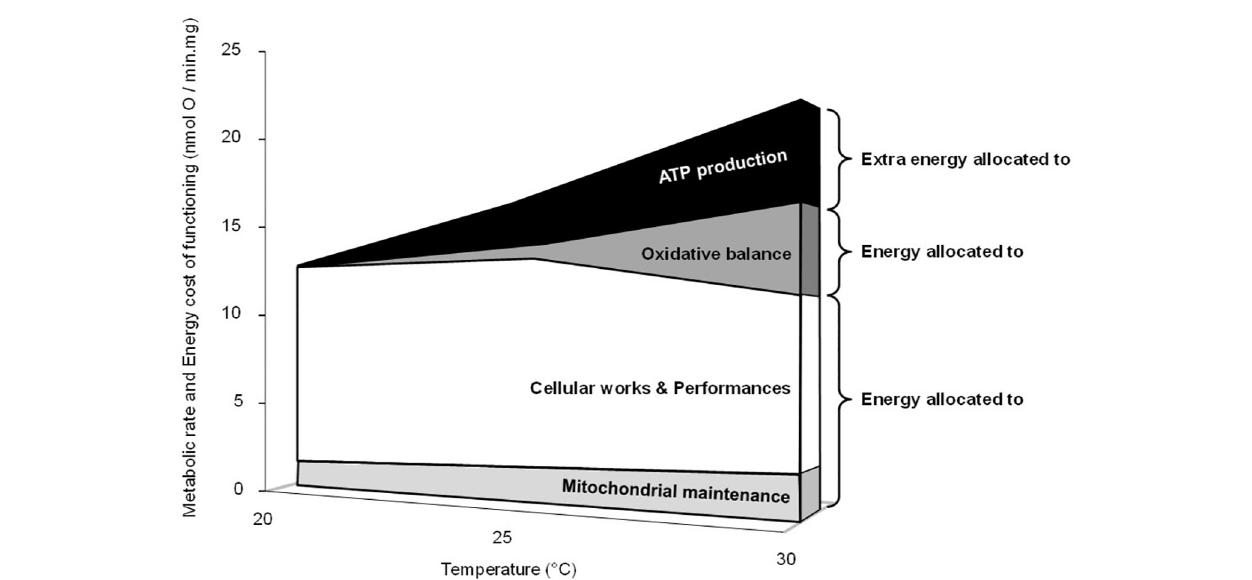
FIGURE 6 | Synoptic summary of the effects of acute temperature change on mitochondrial metabolism and energy costs. The upper limit in the figure represents the positive thermal effect on the maximal phosphorylating oxygen consumption rates (active states in Table 1 ), which is linearly related to the rates of ATP synthesis ( Figure 1A ). The “extra energy allocated to ATP synthesis” is related to the thermal decrease of the coupling efficiency and represents the extra oxygen needed to produce a given amount of ATP. It was calculated by using the percent changes in effective coupling efficiency measured at 25 and 30 ◦ C compared with values at 20 ◦ C (-15 and -22%, respectively; Figure 1B ). The “energy allocated to oxidative balance,” the “oxidative cost,” is related to the thermal increase in H 2 O 2 generation. It was calculated by using the mean value of the differences between the ratios%H 2 O 2 /O and%H 2 O 2 /ATP measured in the phosphorylating active state at 25 ◦ C or at 30 ◦ C and values measured at 20 ◦ C (+7 and +33%, respectively; Table 1 and Figure 4B ). “Mitochondrial maintenance” represents the need for oxygen and substrate consumption to counteract proton leakage and maintain the mitochondrial membrane potential value in active state. Even though the mitochondrial proton leakage is low in the phosphorylating active state, it still occurs, representing between 10 and 15% of the maximal phosphorylating oxygen consumption rate in liver mitochondria (Brand et al., 1993; Roussel et al., 2004, 2018). Here we used the fix value of 11%, arguing that the thermal increase in membrane conductance and subsequent proton leakage was counterbalanced by the thermal increase in the activity of the electron transport system ( Table 1